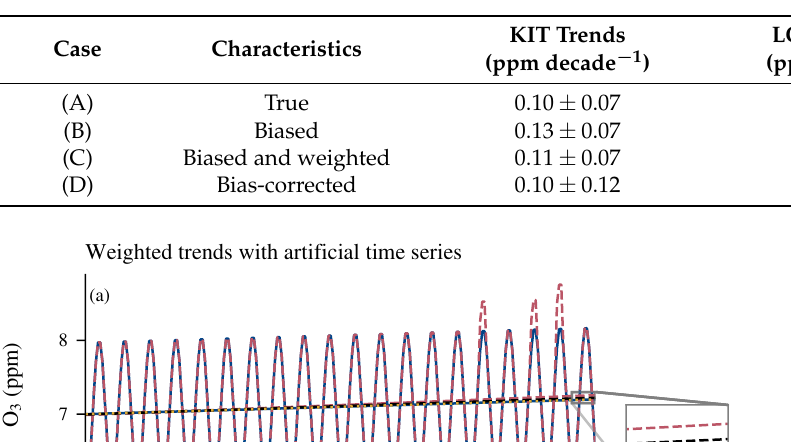
Table 1. Trends for the artificial time series with different corrections as shown in Figure 4, using the KIT and the LOTUS trend model.